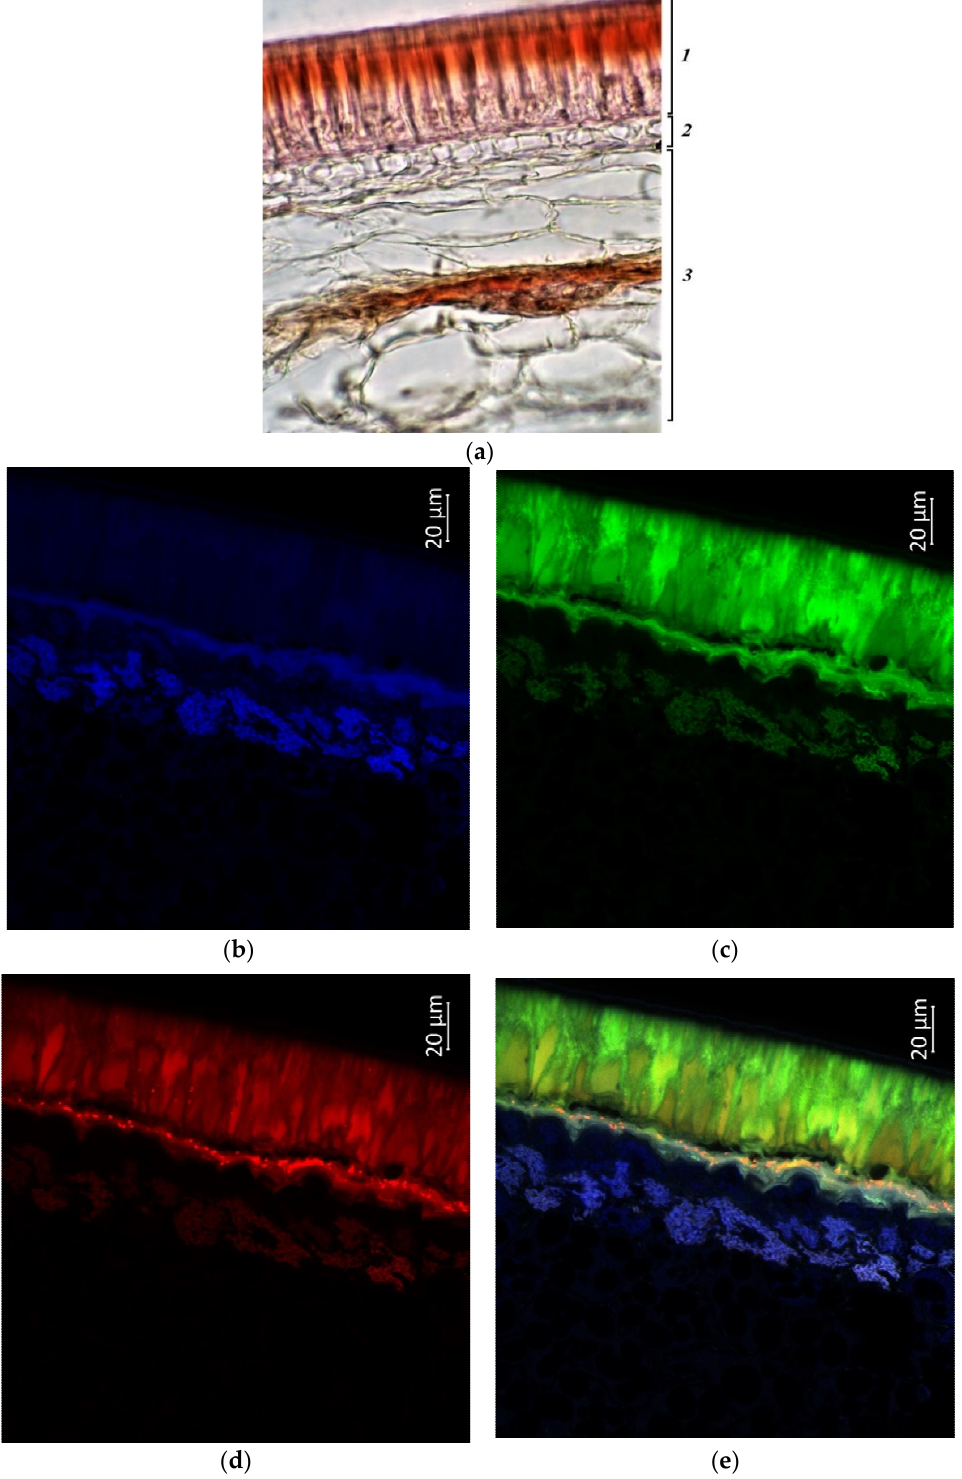
Figure 12. V. unguiculata accession k-632341: ( a )—seed coat structure, light microscopy (1—palisade layer, 2—hypoderma, 3—parenchyma); ( b – e )—transverse section of the seed, confocal microscopy, ( c )—excitation 405 nm with the emission in 400–475 nm (blue), ( c )—excitation 488 nm with the emis- sion in 500–545 nm (green), ( d )—excitation 488 nm with the emission in 620–700 nm (red), ( e )— merged.